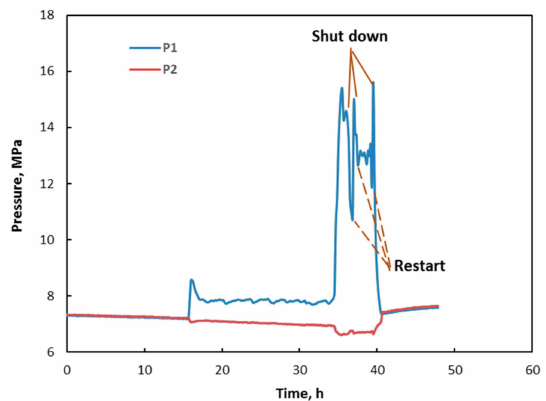
Figure 4. Pressure variation in reactor during hydrate